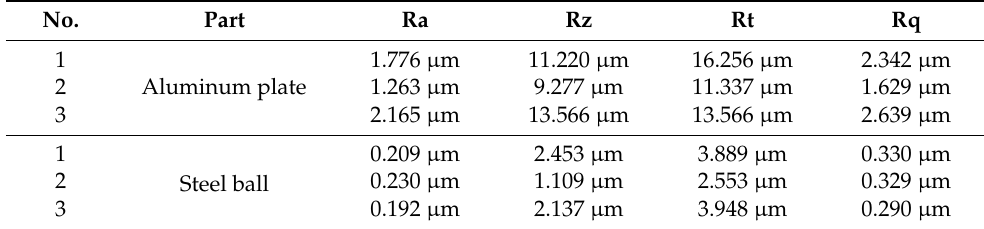
Table 2. Two-dimensional roughness parameters of the contact